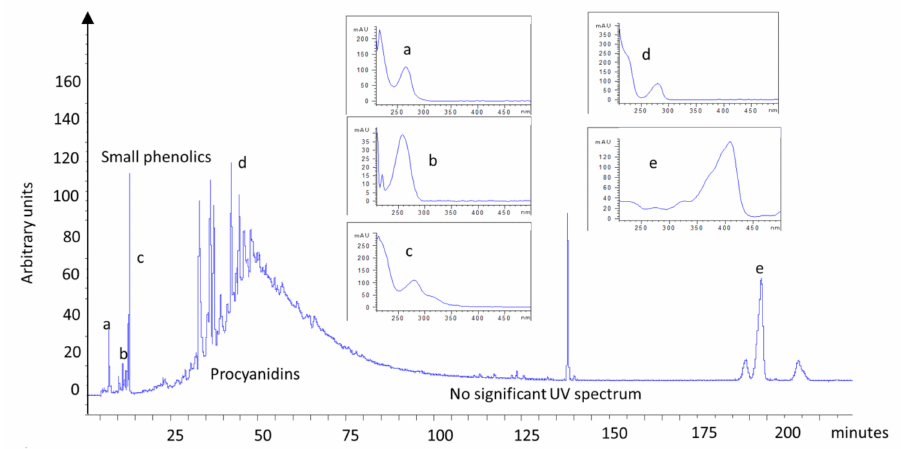
Figure 3. LC-DAD chromatogram of B. retusa bark extract. Superscript letters a,b,c,d indicate UV spectra of selected peaks. ( a – c ), UV spectra of small phenolics; ( d ), UV spectra of procyanidin; ( e ), UV spectra of unknown